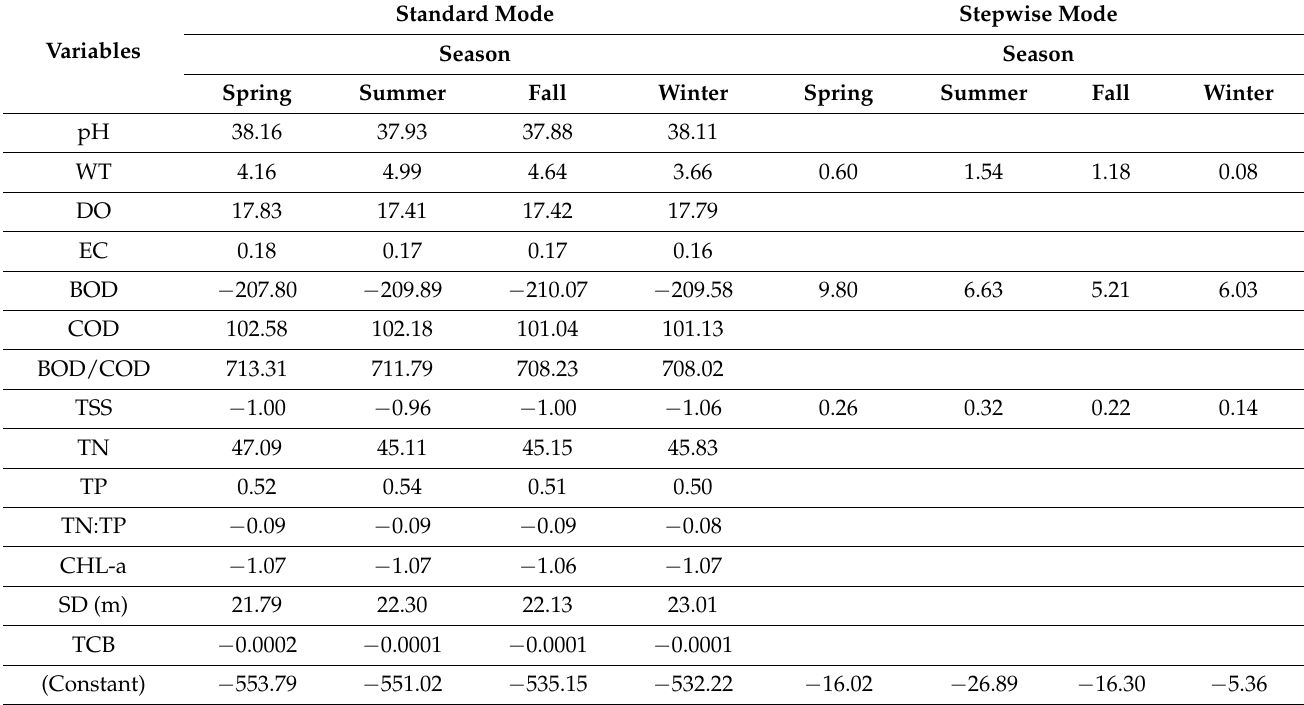
Table 3. Classification functions for discriminant analysis of seasonal variations in water quality of the reservoir.